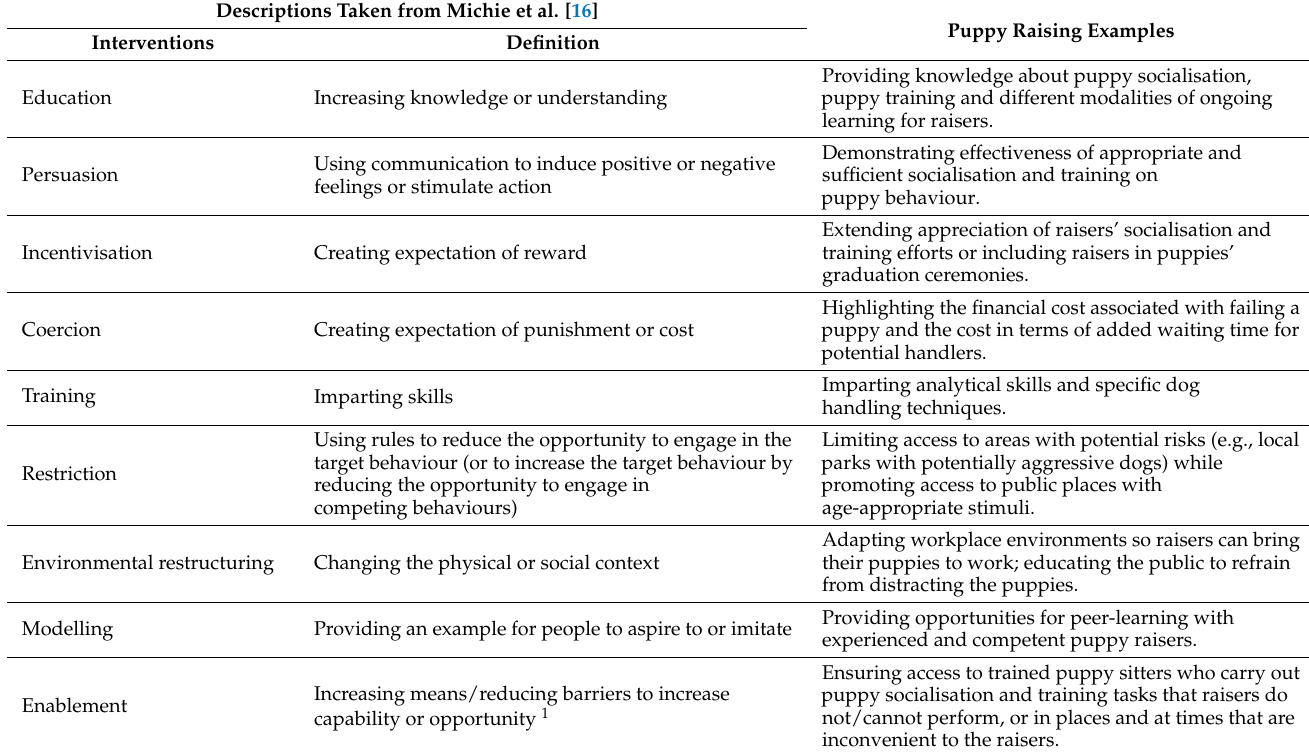
Table 1. Definitions of Behavioural Change Wheel Functions and Puppy Raising